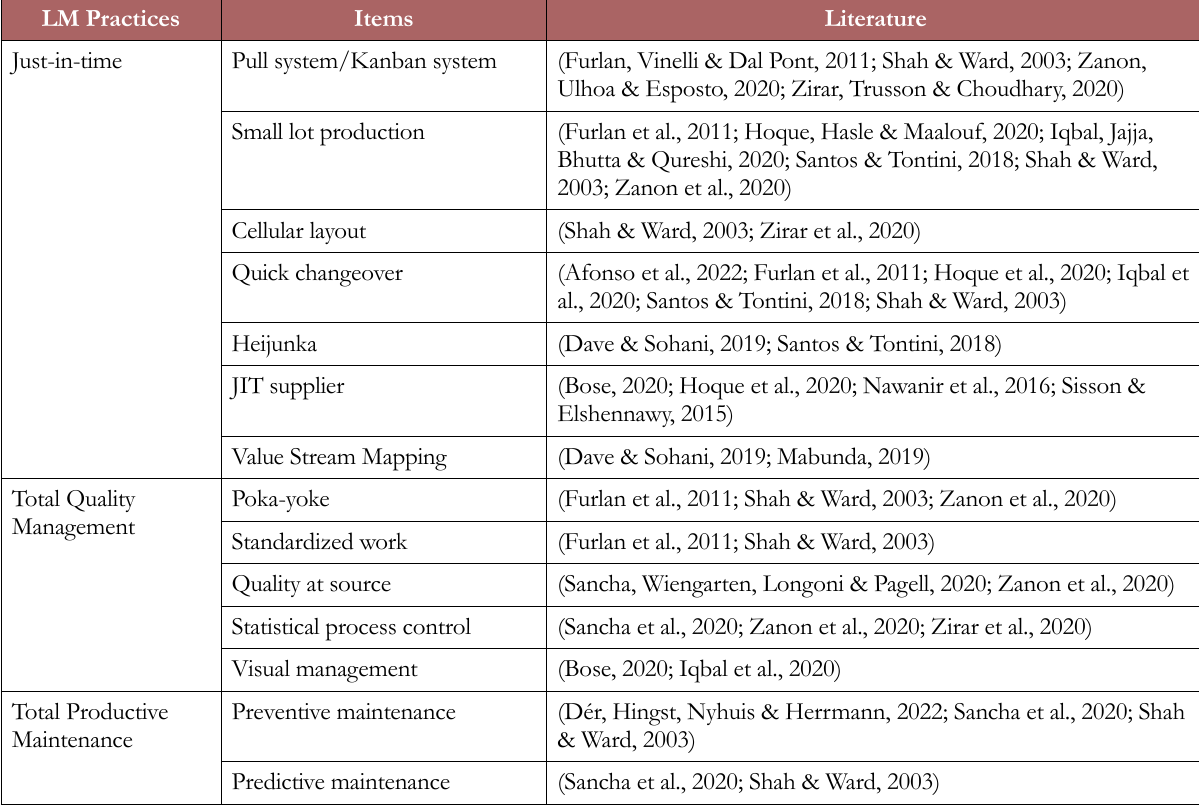
Table 2. Summary of articles in LM